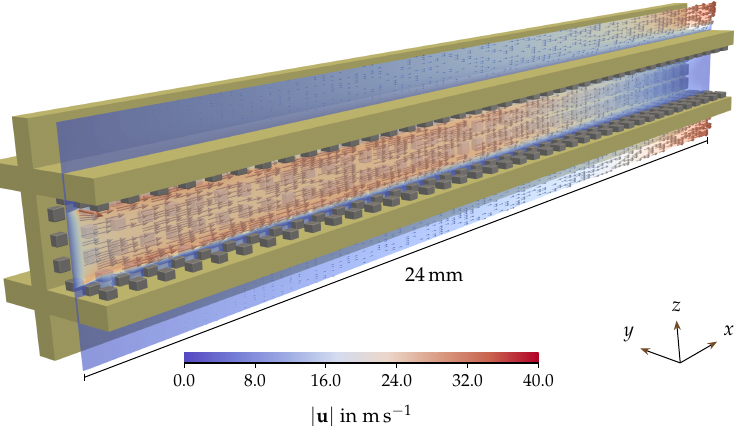
Figure 27. Flow field with fragmented PM layer assuming an increasing substrate coverage beginning from a relative fragment size of d xy , rel = 0.6 in gray. Dark yellow structures represent porous filter substrate. Colour scale indicates local velocity